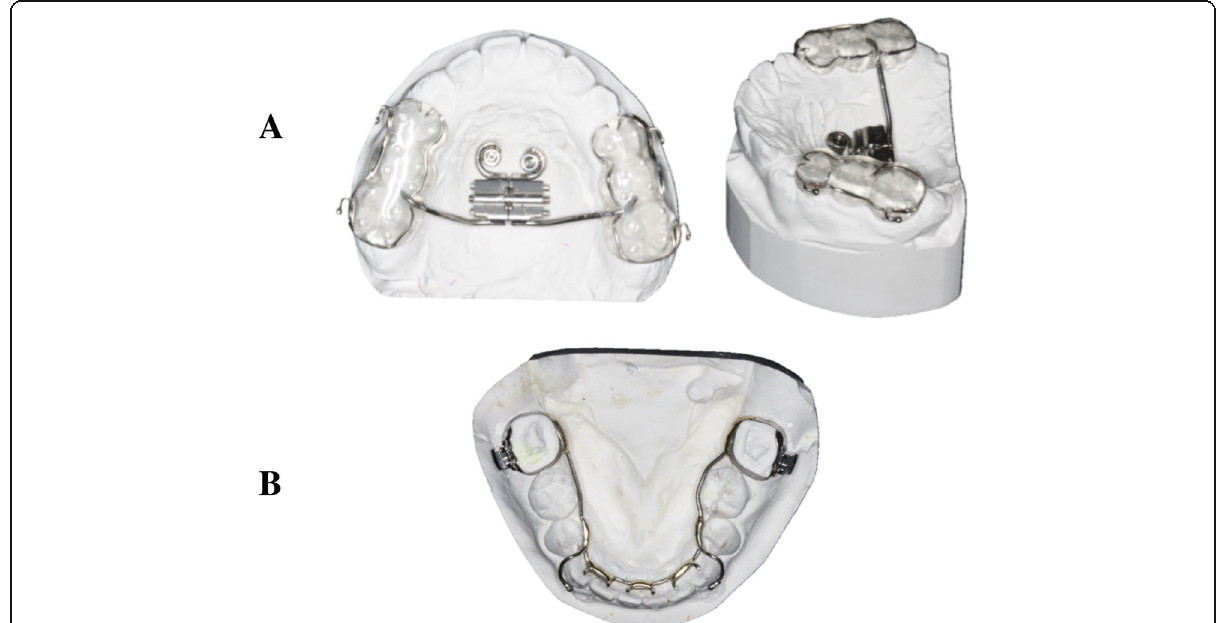
Fig. 2 a Hybrid MARPE. b MLA appliance